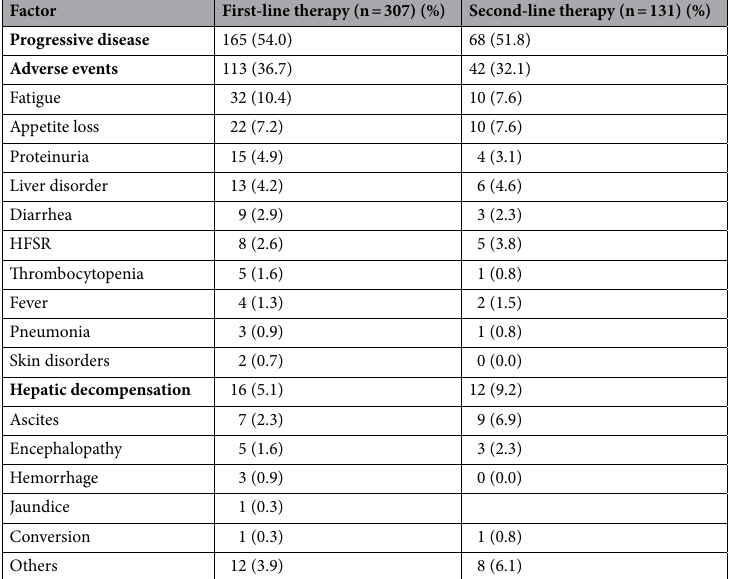
Table 2. The reasons for treatment discontinuation in the first-line and second-line therapy. HFSR hand-foot- syndrome-reaction.